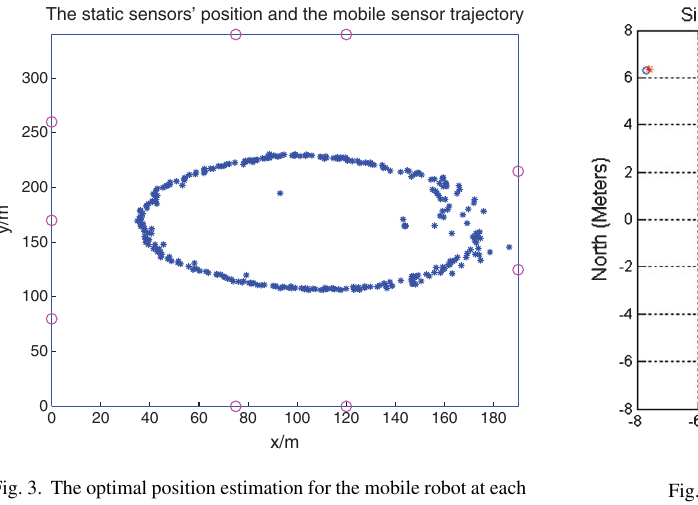
Fig. 3. The optimal position estimation for the mobile robot at each time step.